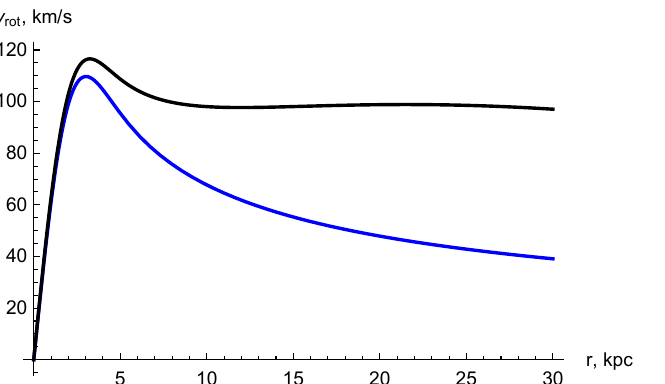
Figure 6. The lower blue curve corresponds to the contribution of a galactic nucleus of baryonic matter, including specifically nucleus, bulge and disk. The upper black curve takes the vacuum Φ -polarization into account. The form factor of a galaxy nuclei is taken as Z ( q ) the accretion rate is of T = 10, i.e., 10 kPc, which corresponds to 32,000 years. The number of the minimally coupled scalar fields is of N sc = 2, and k 2 max = 8 M 2 p π 2 98